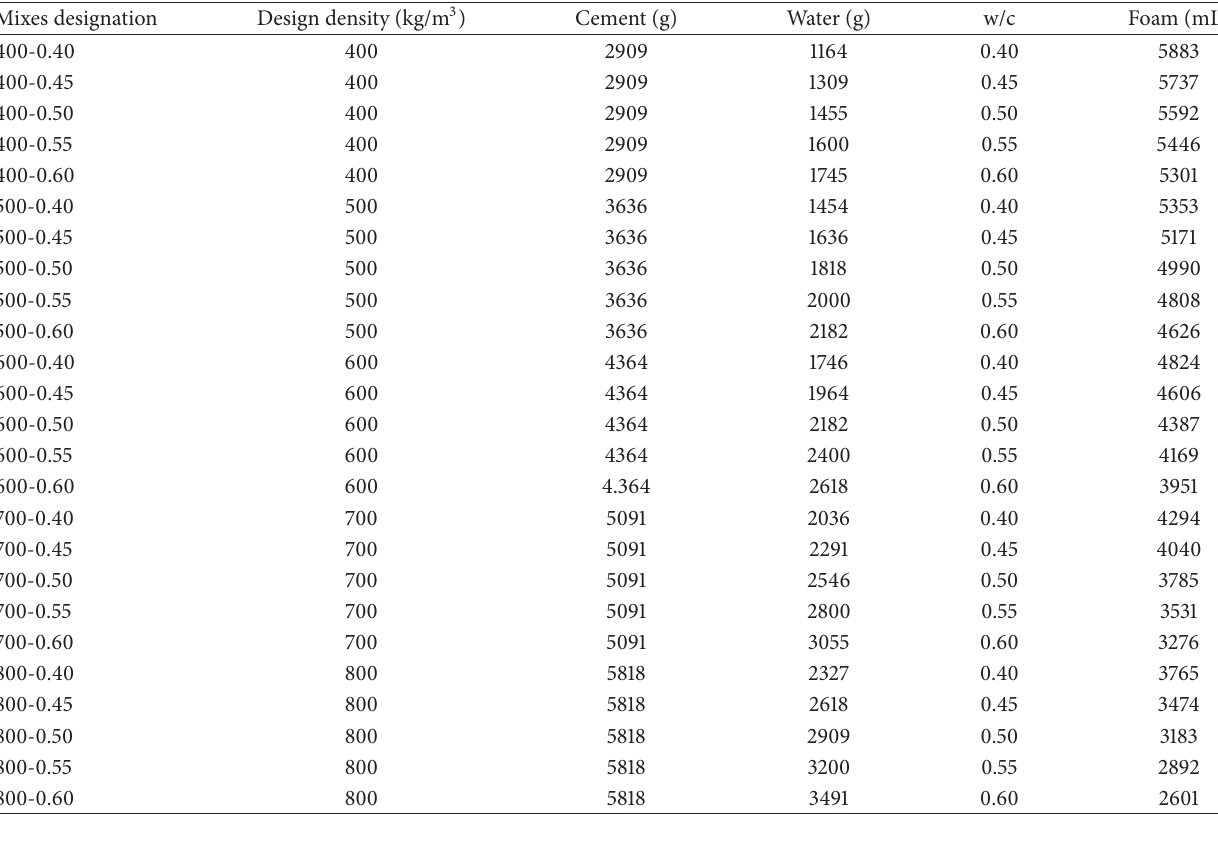
Table 3: Mix proportions of raw materials.